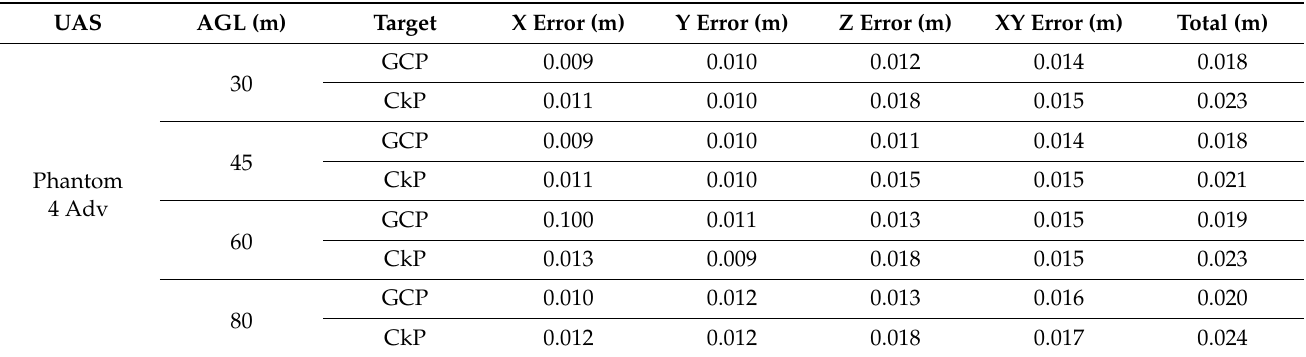
Table 3. Residuals on GCP and CkP for the survey made by the Phantom 4 Adv at different AGLs. Total represents the total error of the 3 components.